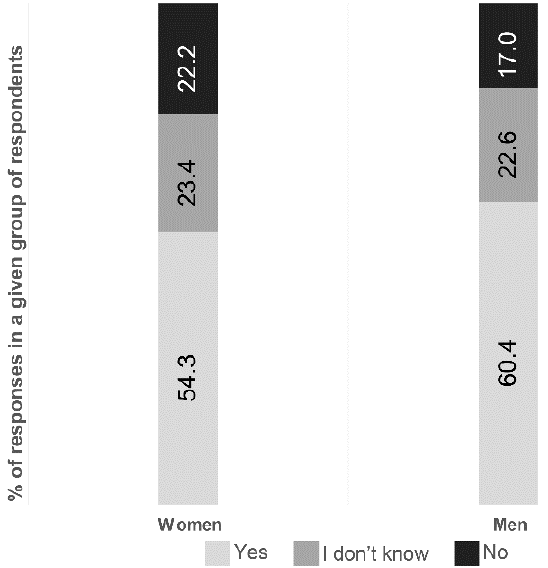
Figure 8. Willingness to change one’s own apartment for a co-housing option, depending on gender.